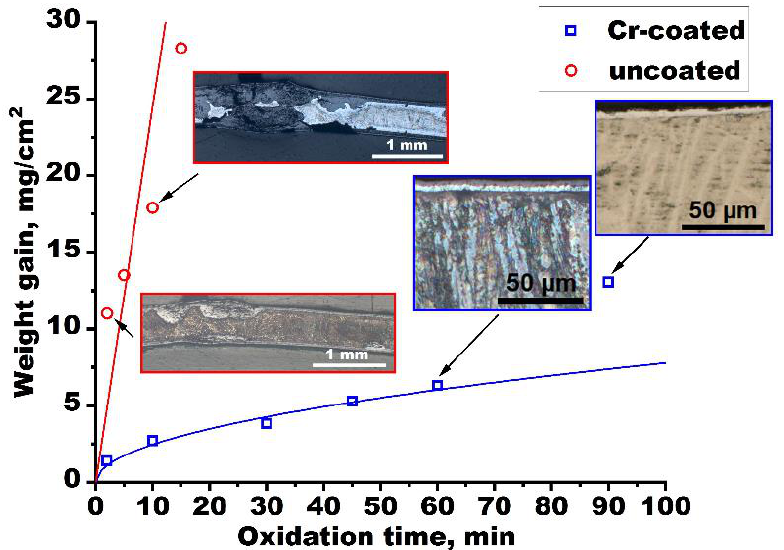
Figure 1. Dependencies of the weight gain of uncoated and Cr-coated LBW E110 alloy samples on oxidation time. Insets show optical images of the cross-section microstructure of the samples in general (uncoated LBW) and in a surface region (for Cr-coated samples).